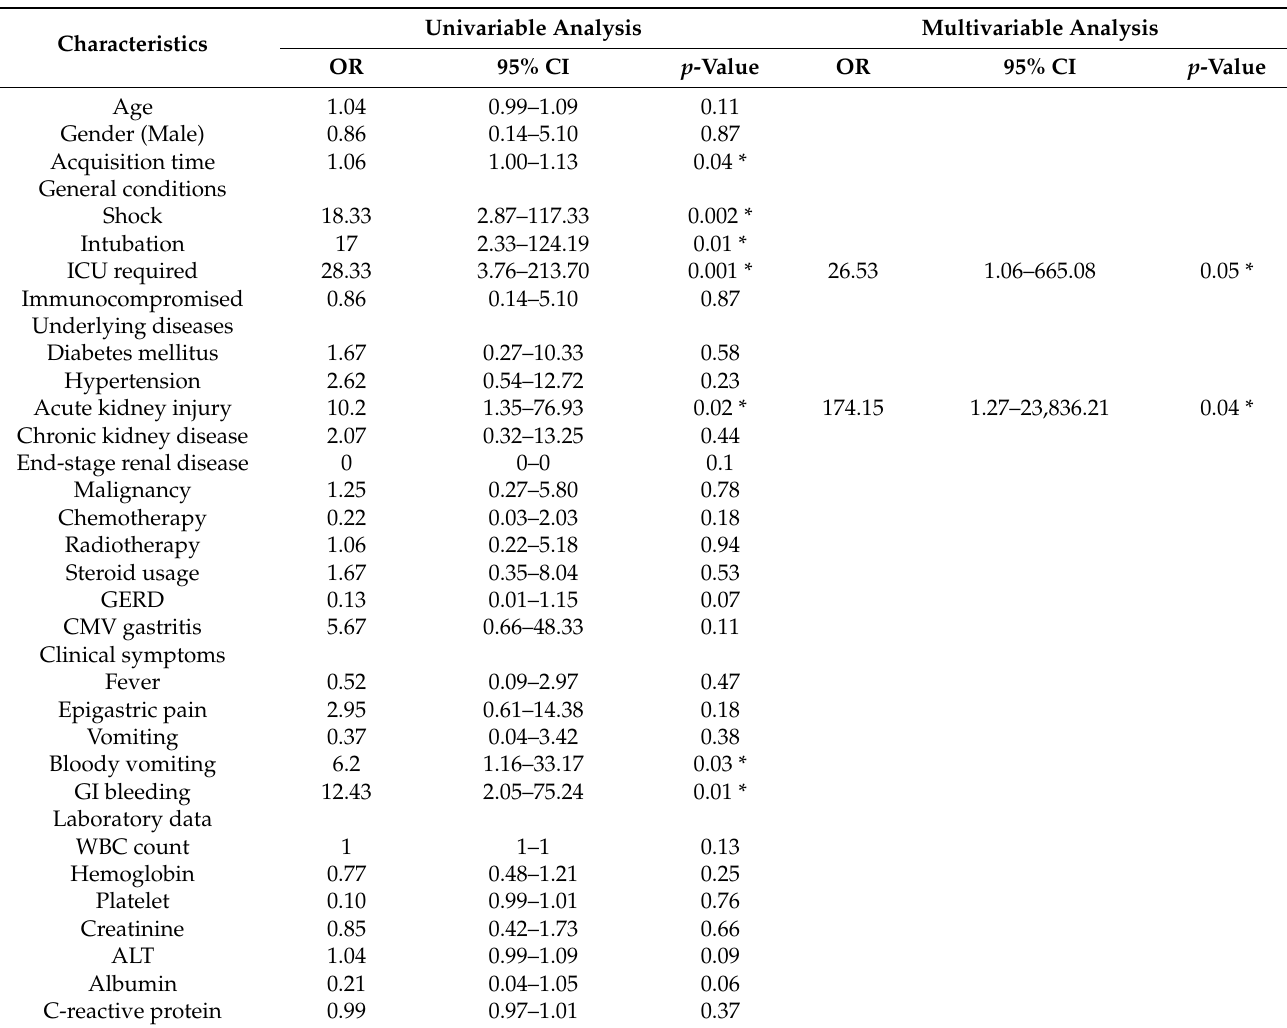
Analysis of clinical factors associated with in-hospital mortality in patients with CMV